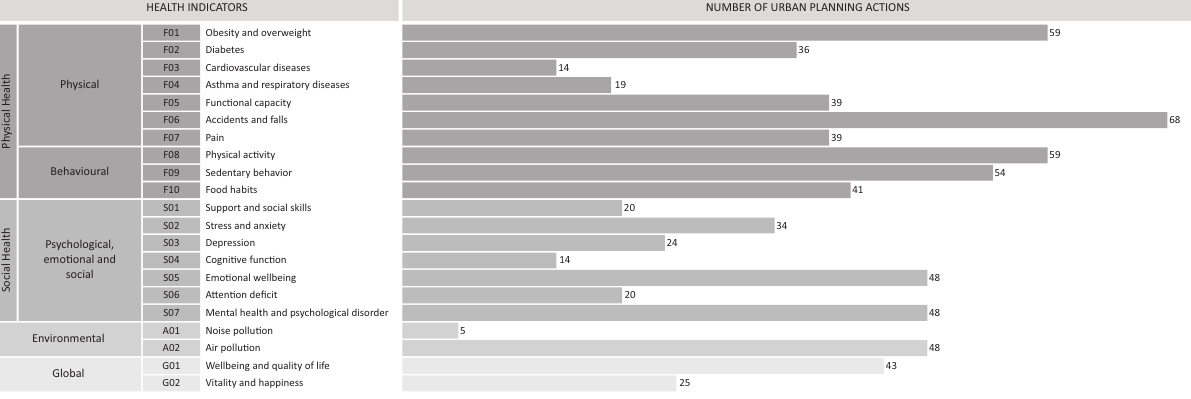
Figure 9. Overview of the number of the urban planning actions included in the Vic urban master plan that relate to the health